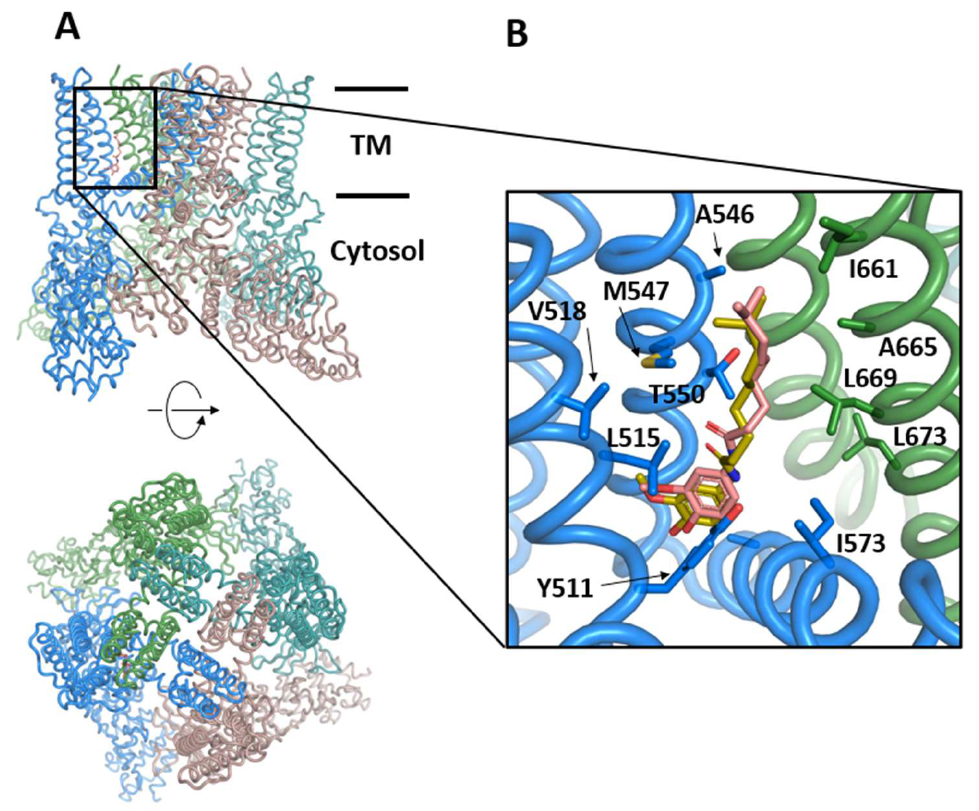
Figure 4. Structure of TRPV1 in the presence of the activator capsaicin, (PDB code: 7LR0). ( A ) Front and top views of TRPV1 in colored illustrations. The horizontal black bars indicate the approximated location of the lipidic membrane and separate the transmembrane (TM) and the cytosolic domains. ( B ) Vanilloid pocket located between two subunits (blue and green) including the capsaicin as determined by cryo-EM (salmon) or re-docked by AutoDock Vina (golden) and the sidechains delineating the pocket.